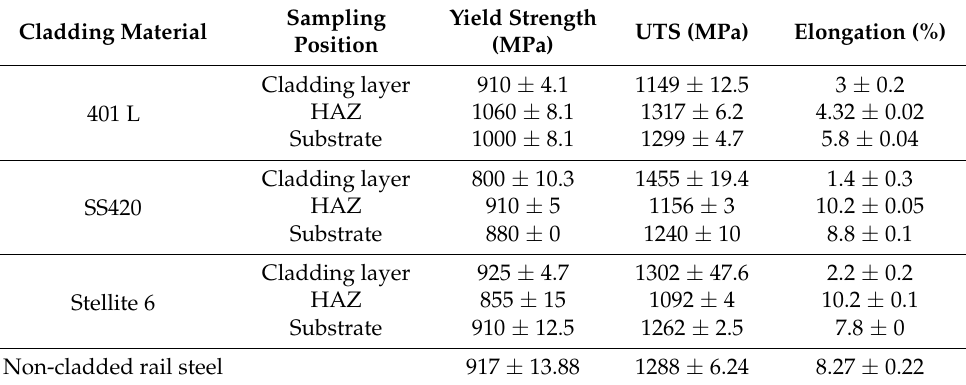
Table 2. Average tensile properties with a standard deviation of the longitudinal specimens from cladded hypereutectoid steel rails (HE400) with different cladding materials